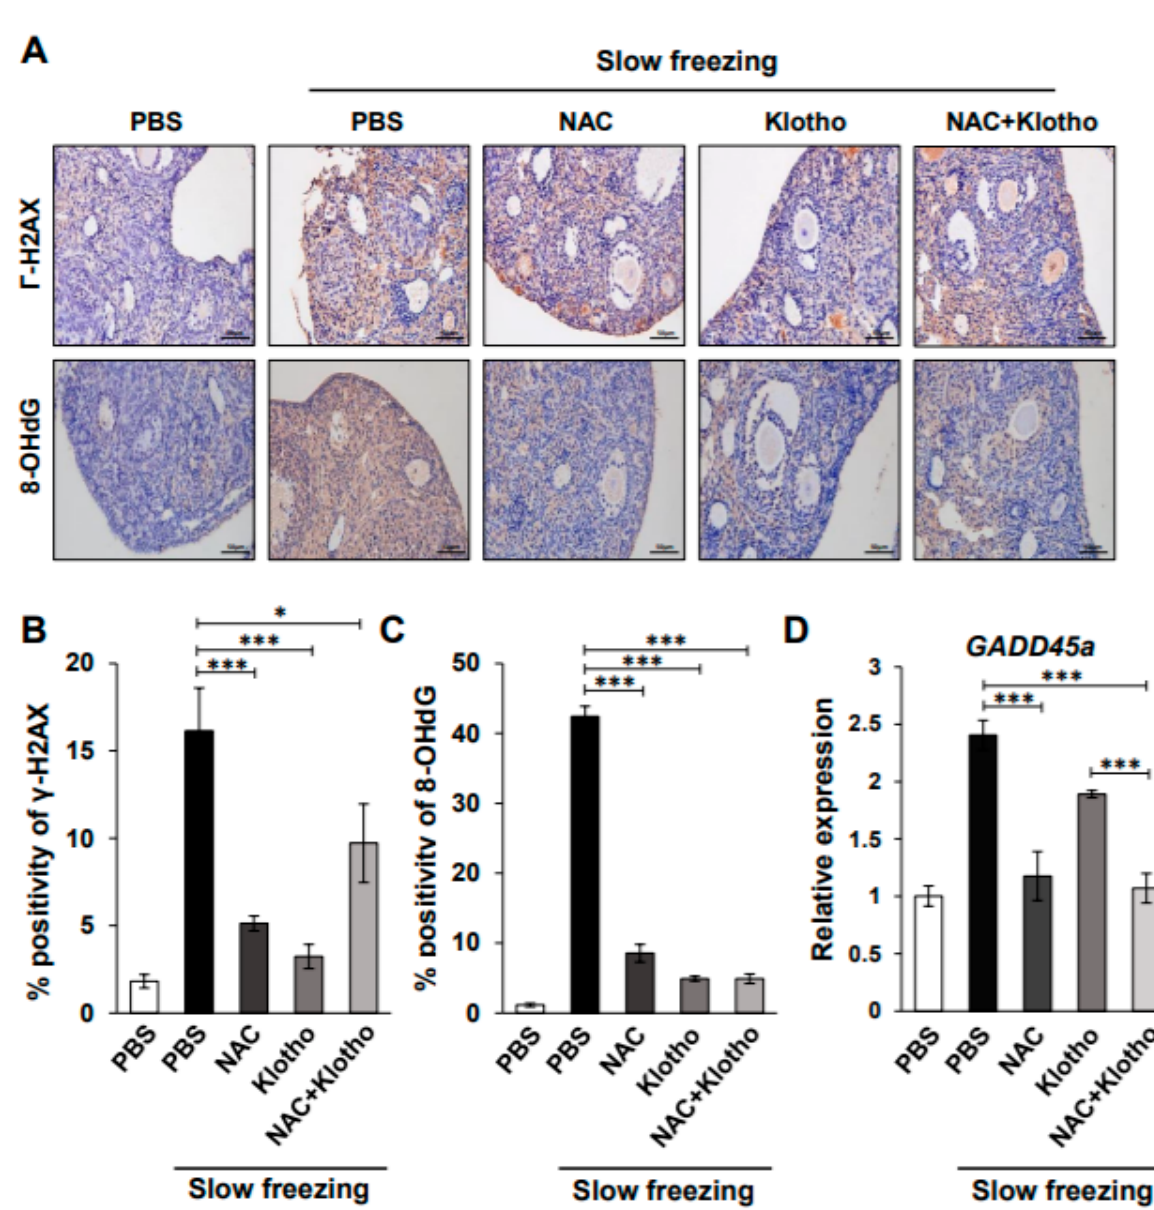
Figure 2. NAC and klotho treatment reduce increased DNA damage and oxidative stress in the slow-freezing method. ( A ) Representative IHC images at 400x magnification showing double-stranded breaks (DSBs) and 8-hydroxy-2 ′ -deoxyguanosine (8-OHdG) in the indicated conditions. Brown indicates DSBs-positive (top) and 8-OHdG-positive in the ovarian tissue (bottom). ( B , C ) Graph showing the average percentage of DSBs ( B ) and 8-OHdG ( C ) in the IHC images. ( D ) qPCR results showing relative expression levels of GADD45a . All data are shown as mean ± SD. The p values were determined by one-way analysis of variance (ANOVA). * p < 0.05; *** p < 0.0001. n = 6 each group. Each experiment was repeated three times.